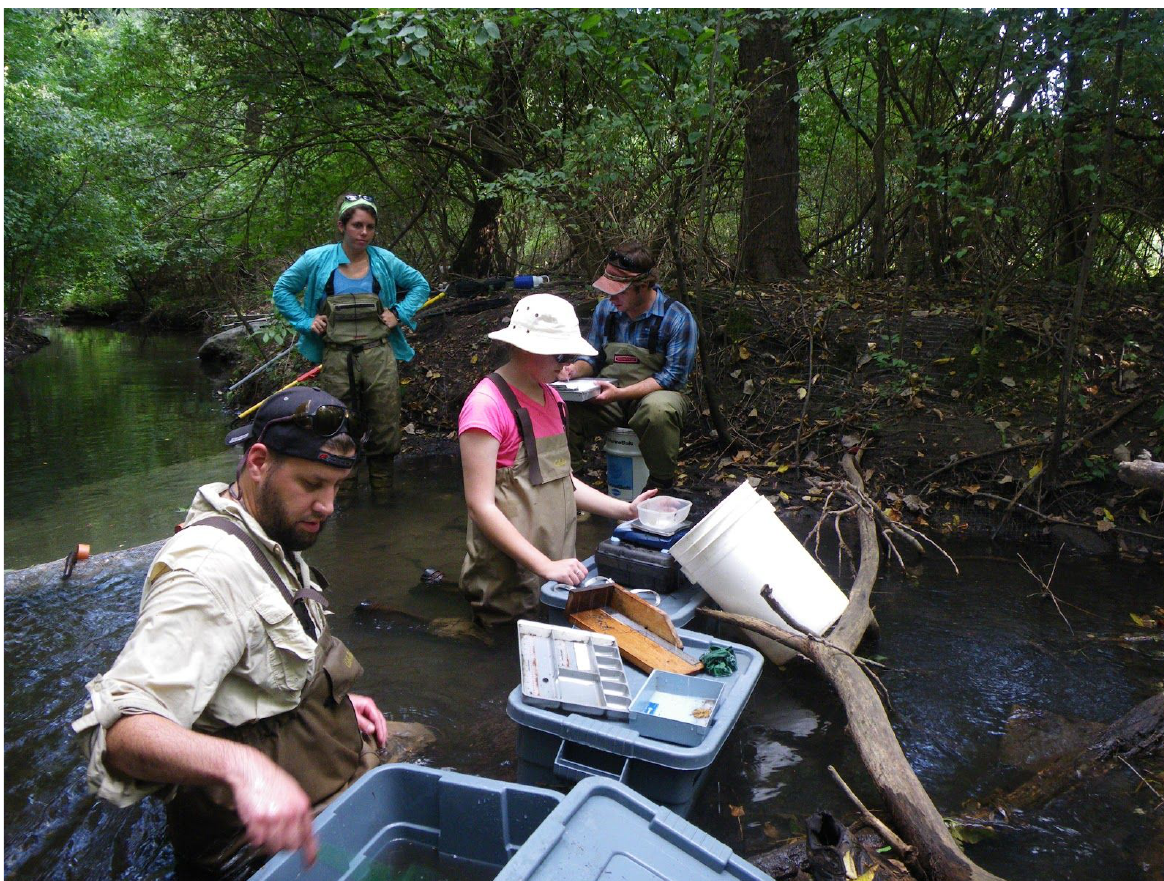
Figure A1.5. Kelly Heilman, Dayna (Smith) Evans, and Brandon Gerig helping Michael Brueseke measure fish on Sep. 11,